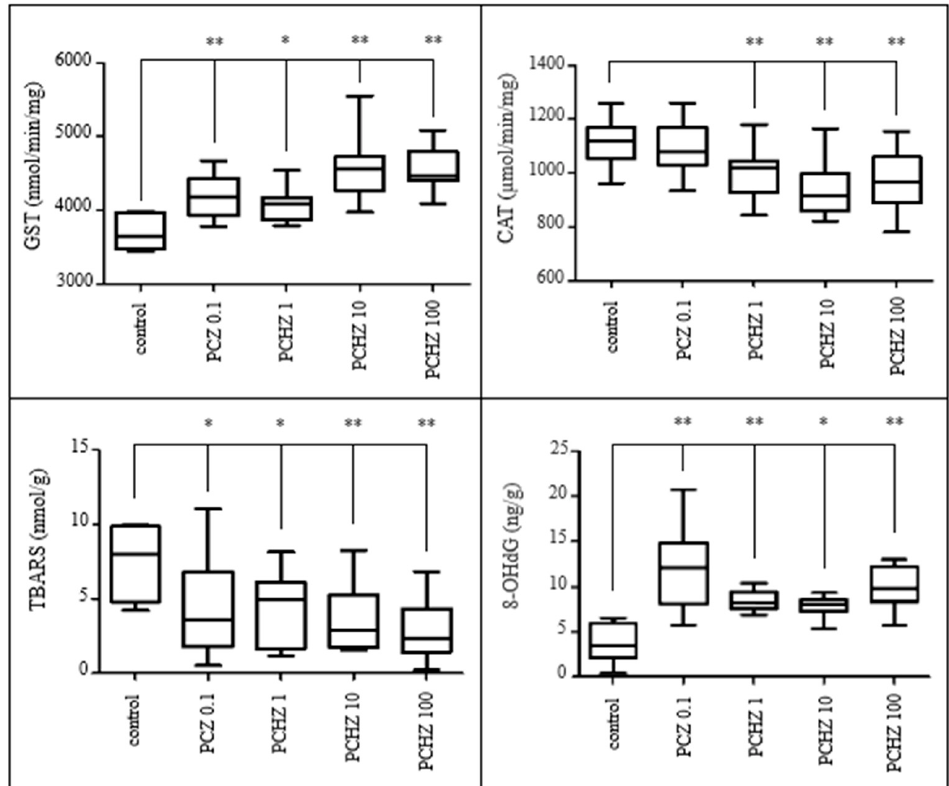
Figure 9. Results of various oxidative stress indices in C. carpio larvae after exposure to PCZ (expressed to mg or g tissue). Concentrations are indicated in µg/L. Box plot graphs were constructed using median, Q1, and Q2 with whiskers of a maximum 1.5 interquartile range. Statistically significant di ff erences are indicated by * ( p < 0.05) or ** ( p < 0.01).